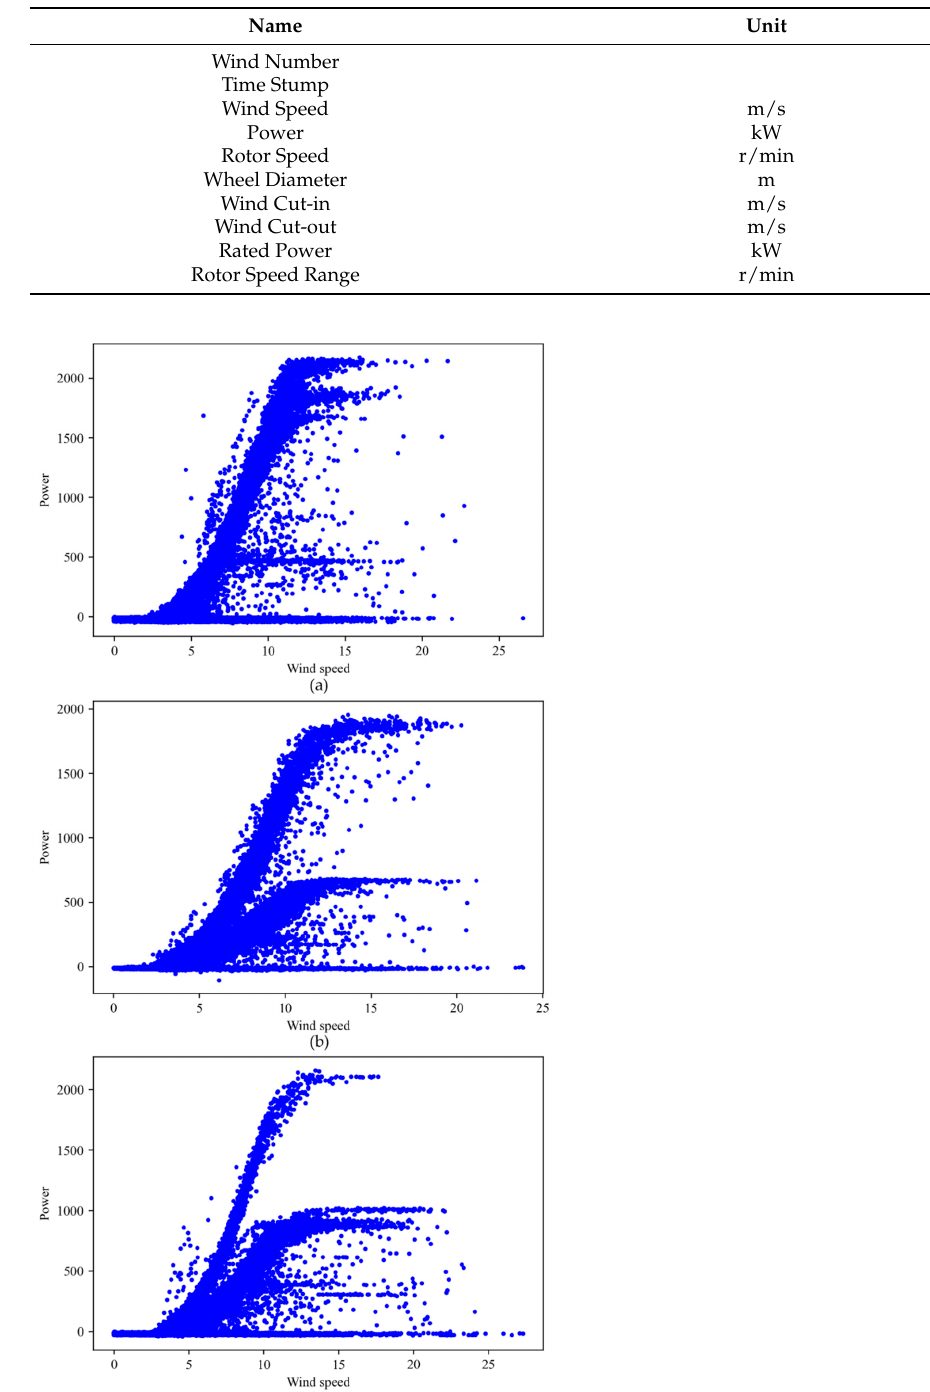
Table 1. SCADA data information.